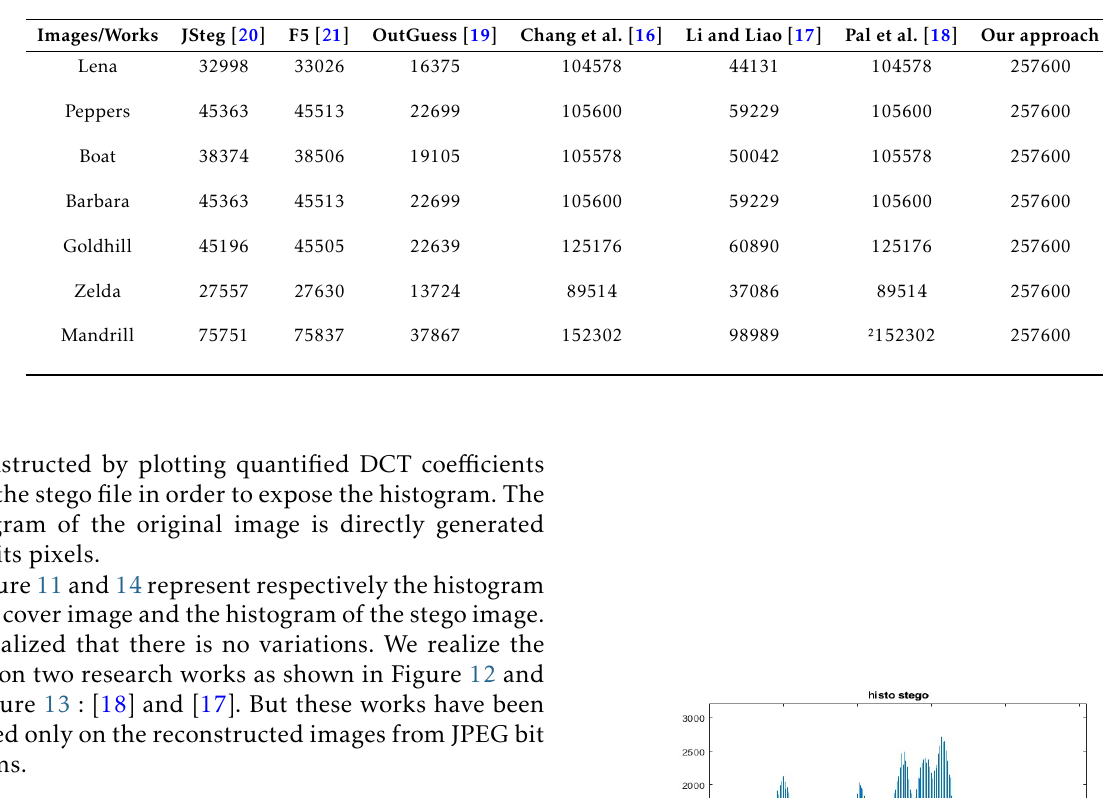
Table 3: Our approach vs. similar works in terms of insertion capacity (in bits)